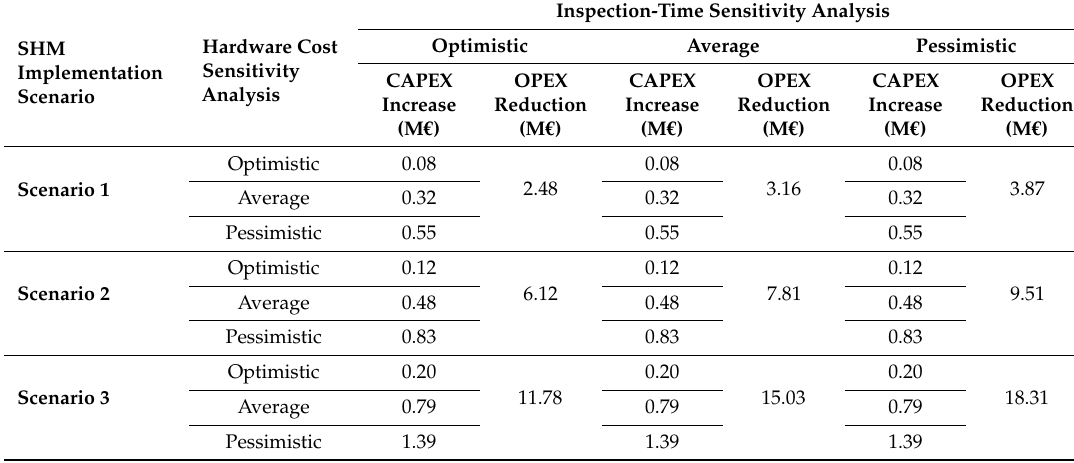
Table 19. CAPEX increase versus OPEX reduction due to SHMS implementation.